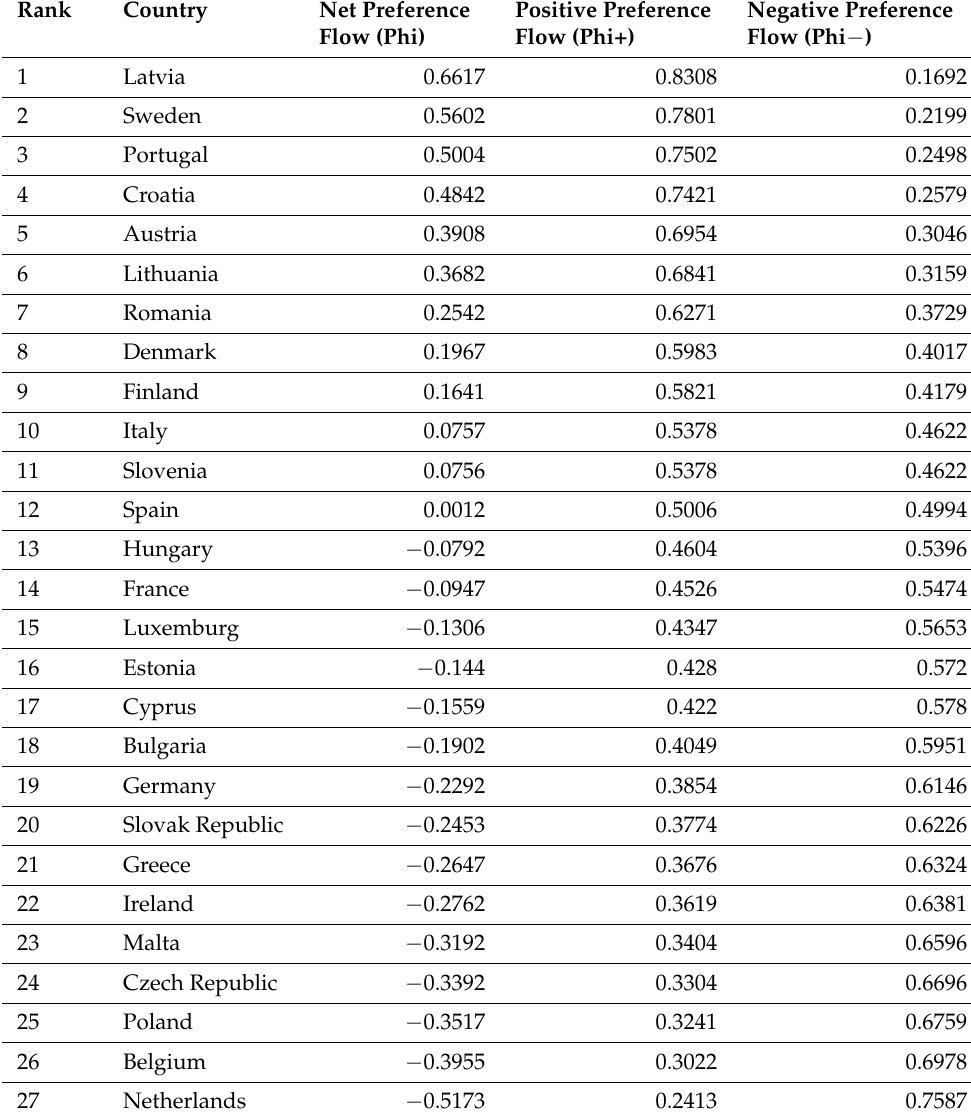
Table 3. Ranking of EU countries for